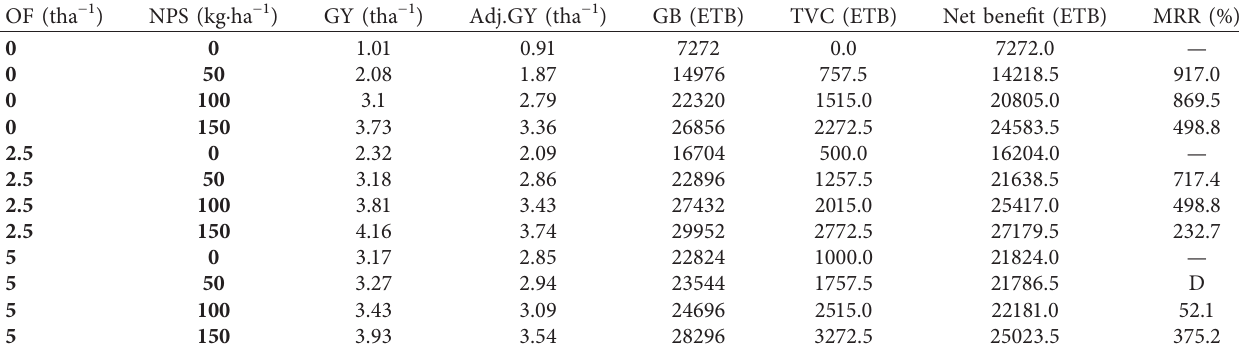
Table 5: Profitability as affected by NPS and OF fertilizer